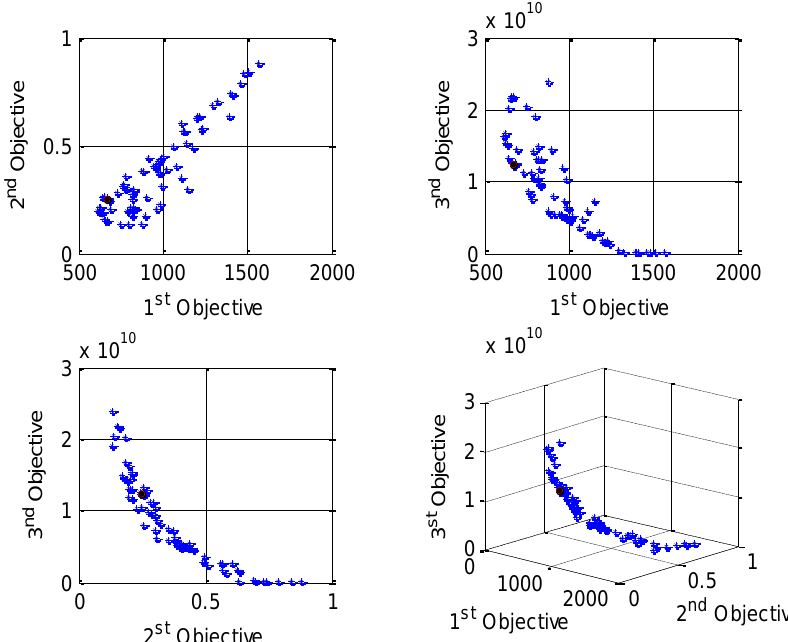
Figure 11. Pareto solution set, MSSA algorithm (first scenario).